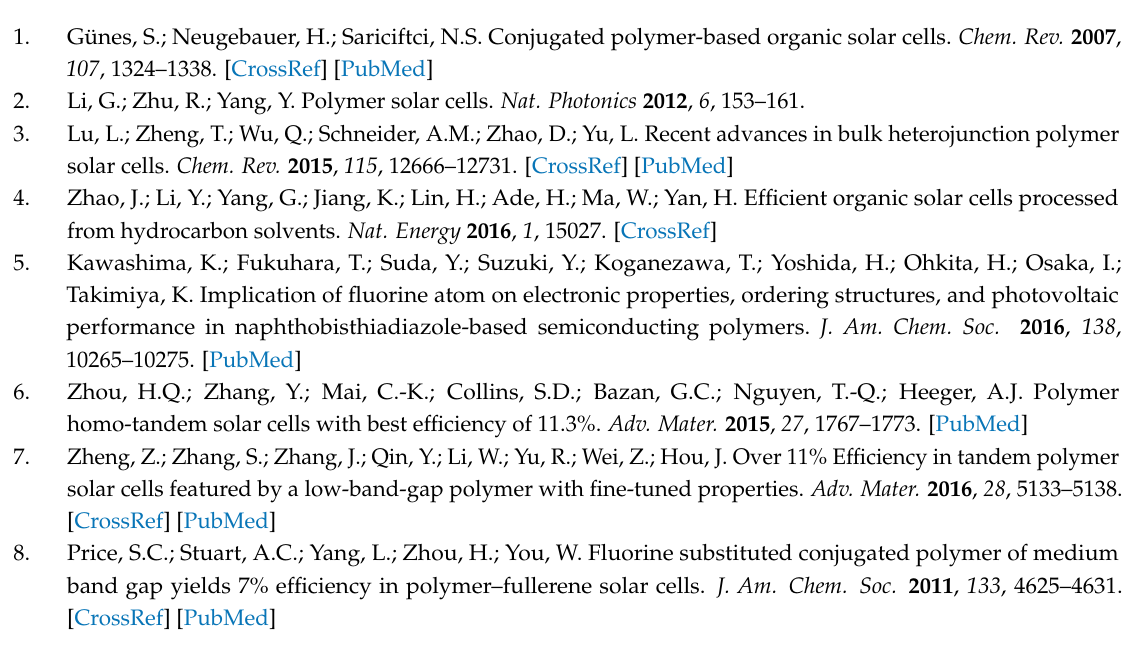
Figure S1: Space-charge-limited J - V curves of hole-only devices based on copolymer/PC 71 BM blend films; Table S1: Calculated hole mobilities of copolymer/PC 71 BM blend